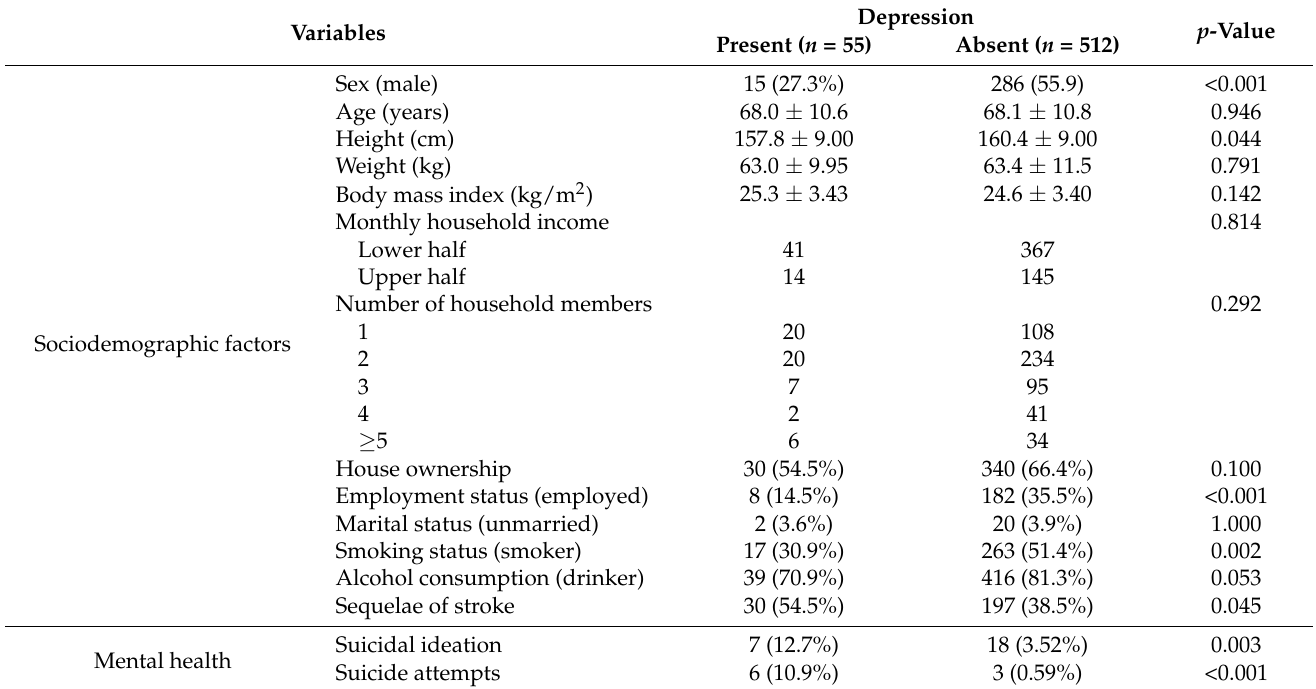
Table 3. A comparison of the study subjects with and without depression retrieved from the Korea National Health and Nutrition Examination Survey (KNHANES) (2016–2019).